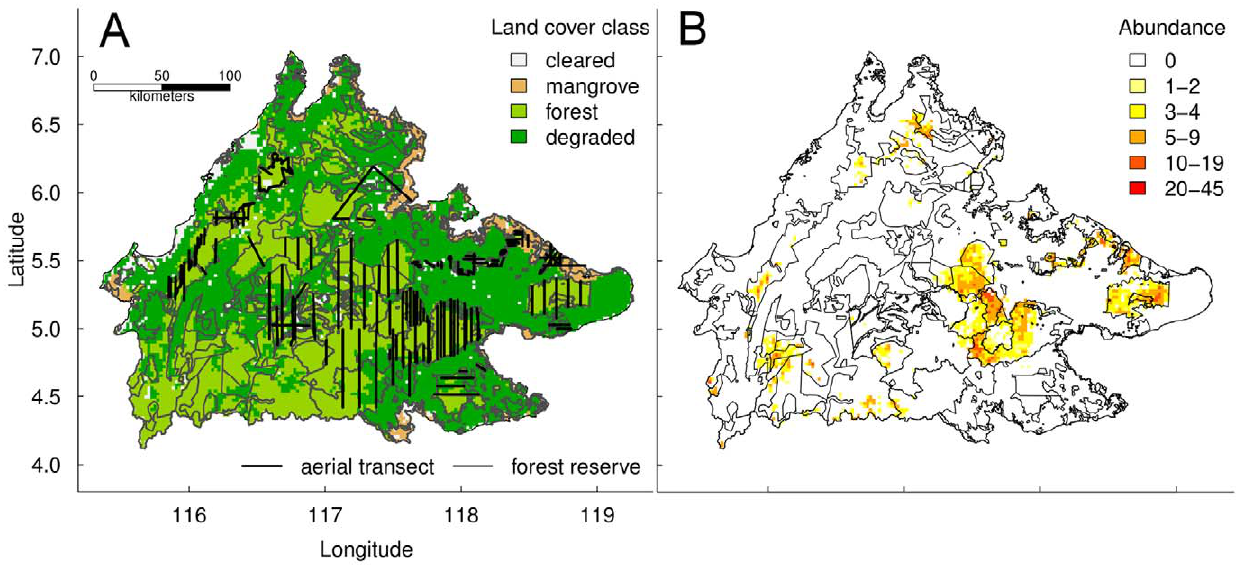
Figure 1. Observed and predicted orangutan nest distributions. Maps showing (a) the distribution of orangutan nest counts across Sabah in all survey years and (b) the hurdle Species Distribution Model predictions for the present day.